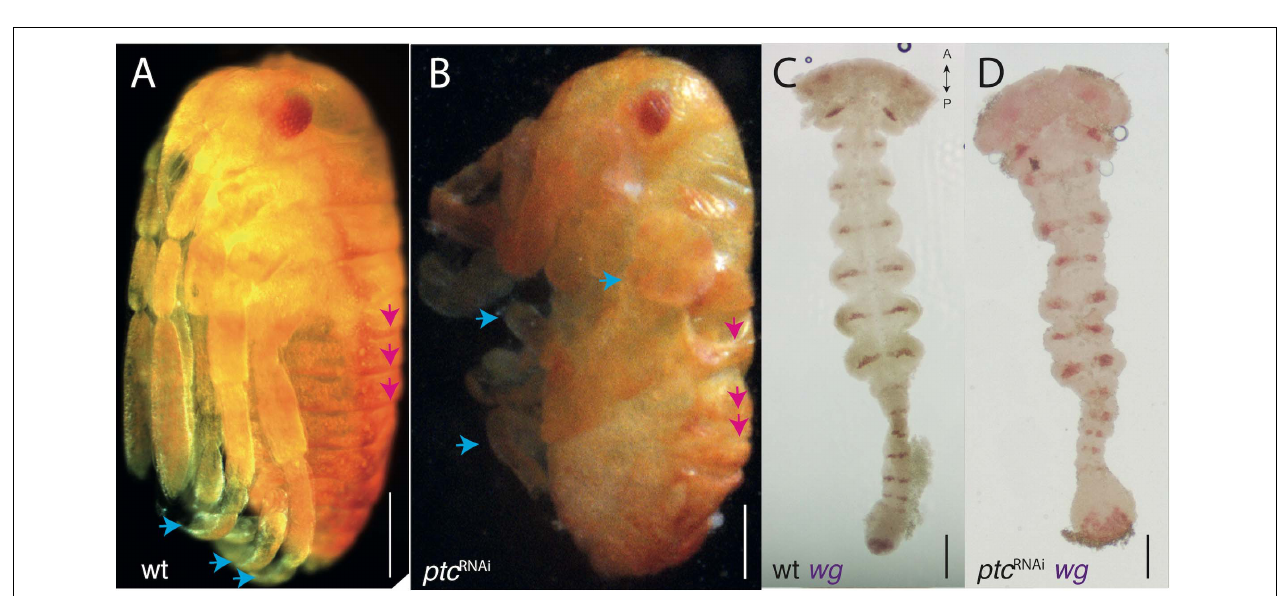
FIGURE 2 | hh -RNAi phenotypes. (A,B) side and front view of a wild-type hatchling, the labrum (outlined with a solid line) covers the mandibles and the antennae lie to its sides. (C) A side view of a hatchling with a reduced labrum, exposing the mandibles following a hh -RNAi. (D) Front view of the same hatchling as (C) showing malformed stubby antennae (outlined with dashed lines). (E) Outline sketch of a germband stage embryo, showing the different regions (based on panel F ). (F) Wild-type germband expression of wg in the mid germband stage. (G) hh- RNAi germband expression of wg , the antennal expression missing. (H) Wild-type expression of wg in the blastoderm (the same embryo from Figure 1G ). (I) hh- RNAi expression of wg in the blastoderm, the antennal segmental stripe is missing. Abbreviations as in Figure 1 . Axis labels: A, anterior; P, posterior; D, dorsal; V, ventral. All scale bars are 200 µ m.